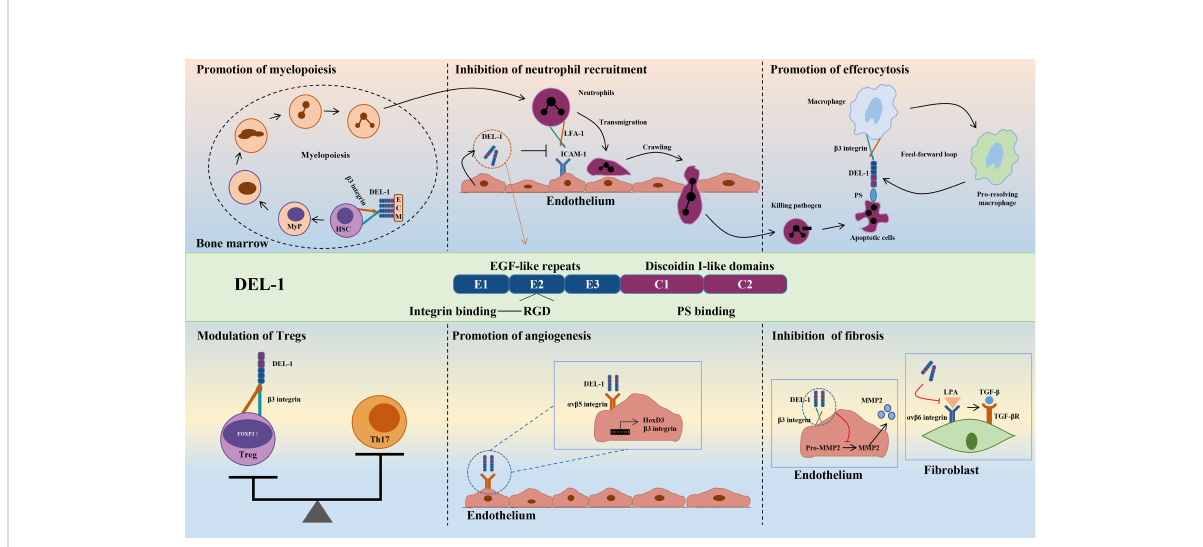
FIGURE 2 Structure and biological roles of DEL-1. The fi gure shows the multidomain structure of DEL-1 as well as six major regulatory activities of this protein, namely, promoting myelopoiesis, inhibiting neutrophil recruitment, promoting efferocytosis, modulating Tregs, promoting angiogenesis and inhibiting fi brosis. DEL-1, developmental endothelial locus-1; ECM, extracellular matrix; HSC, hematopoietic stem cell; MyP, myeloid progenitors; ICAM-1, intercellular adhesion molecule-1; LFA-1, lymphocyte function-associated antigen-1; PS, phosphatidyl serine; Th17, T helper 17 cell; Treg, T regulatory cell; FOXP3, forkhead box P3; HoxD3, homeobox D3; MMP2, matrix metallopeptidase 2; LPA, latency- associated peptide; TGF- b , transforming growth factor- b